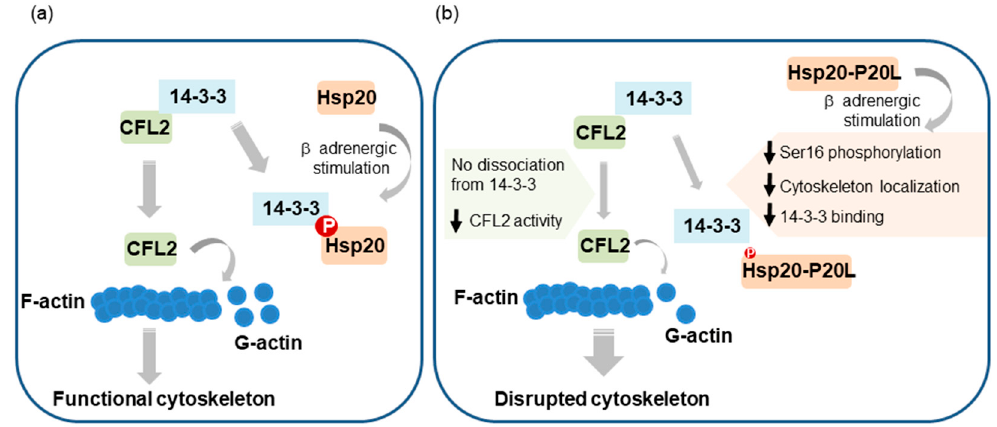
Figure 8. Graphical representation of the proposed contribution of Hsp20 phosphorylation to the regulation of actin cytoskeleton dynamics. ( a ) Hsp20 phosphorylation by PKA during β -adrenergic stimulation leads to Hsp20 subcellular translocation to the cytoskeleton, where it interacts with 14-3-3. For this association to occur, phosphorylated Hsp20 competes with CFL2 for 14-3-3-binding that results in CFL2 dissociation from 14-3-3. This triggers CFL2 activation, leading to enhanced F-actin depolymerization activity and regulation of actin dynamics in order to maintain cytoskeletal integrity and function. ( b ) The human phosphorylation impairing Hsp20-P20L mutated protein exhibits diminished phosphorylation at Ser16 and significantly reduced binding to 14-3-3, with consequent failure to displace CFL2 from 14-3-3. As a result, aberrant regulation of CFL2-mediated F-actin depolymerization. This would lead to cytoskeletal disruption and myofibrillar damage during stress conditions, contributing towards cardiac dysfunction.